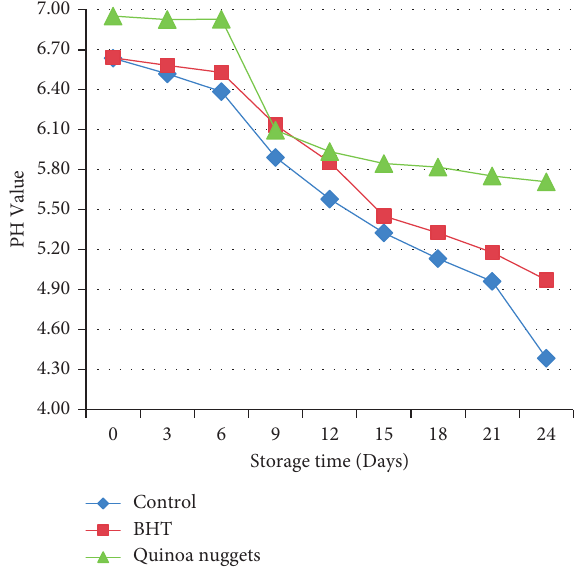
Figure 3: pH values of chicken nugget samples during storage at 4 ° C for 24 days.